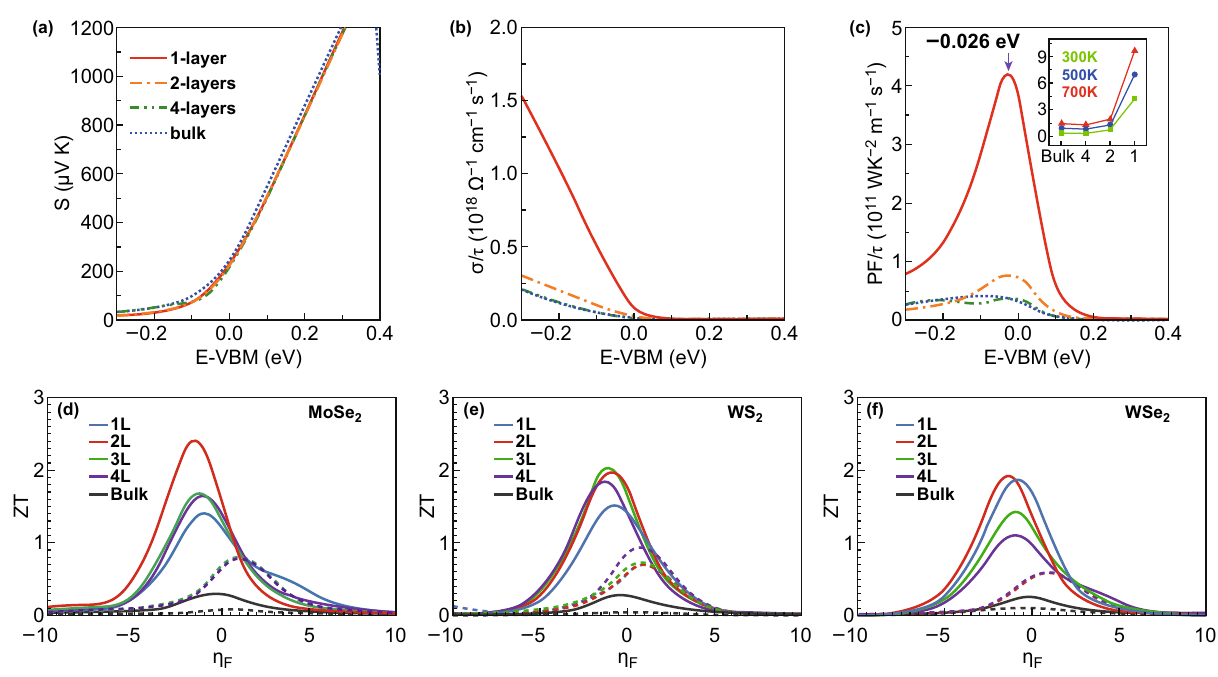
Fig. 2 a In-plane Seebeck coefficient, b electrical conductivity, and c power factor of p-type MoS 2 at 300 K depending on their thickness and chemical potential. Reproduced with permission from Ref. [73]. Copyright 2016, American Physical Society. ZT at 300 K for d MoSe 2 , e WS 2 , and f WSe 2 for bulk (black), 1 layer (blue), 2 layers (red), 3 layers (green), and 4 layers (purple) structures as a function of the reduced Fermi energy, η F . The n -type ZT is plotted with a solid line and p -type ZT with a broken line. Reproduced with permission from Ref. [90] Copyright 2014, AIP Publishing. (Color figure